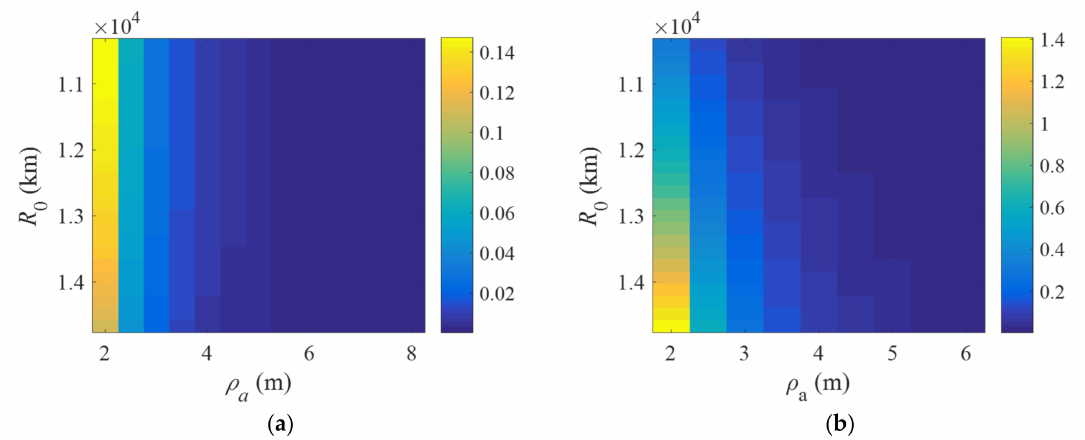
Figure 11. Dependency between the phase error of the cubic-approximated range equation and ρ a and R 0 for the C band system. ( a ) Targets with constant speeds and ( b ) accelerating targets. In the figures, the color indicates the value of the phase error, and the unit is radian.